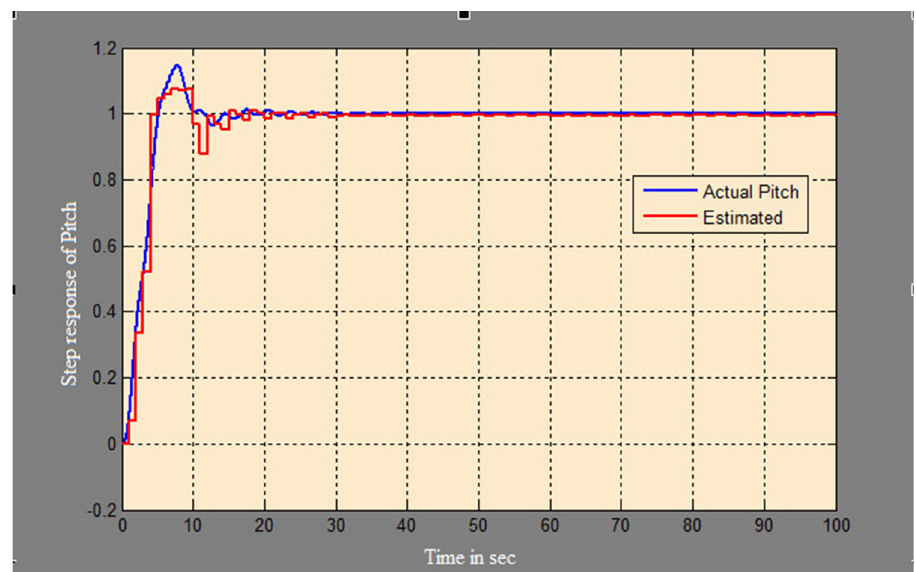
Figure 15. Estimation of the pitch with the neural network model.